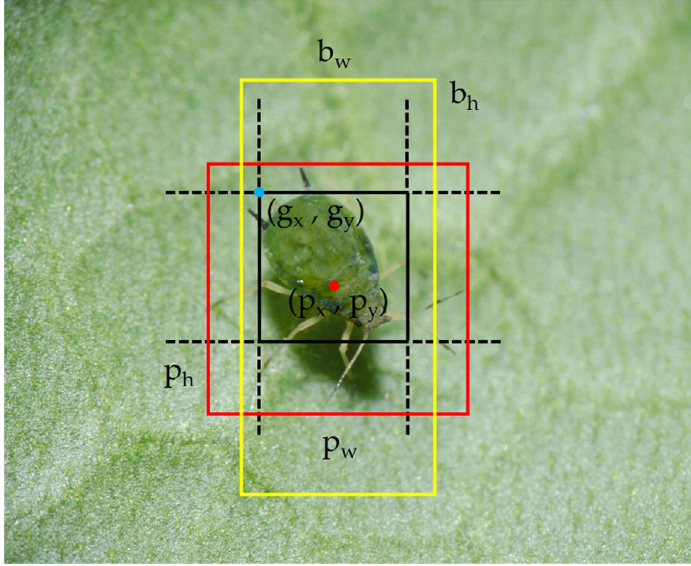
Figure 2. The process of generating prediction boxes.